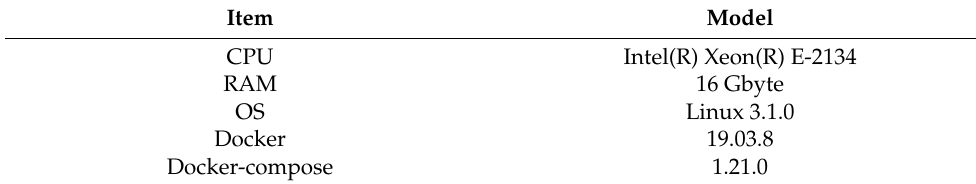
Table 2. Hardware and software